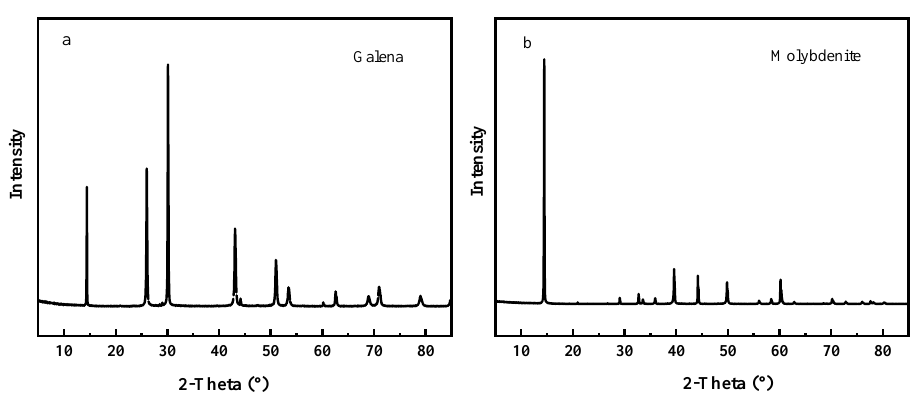
Figure 1. XRD spectra of ( a ) galena and ( b ) molybdenite sample.